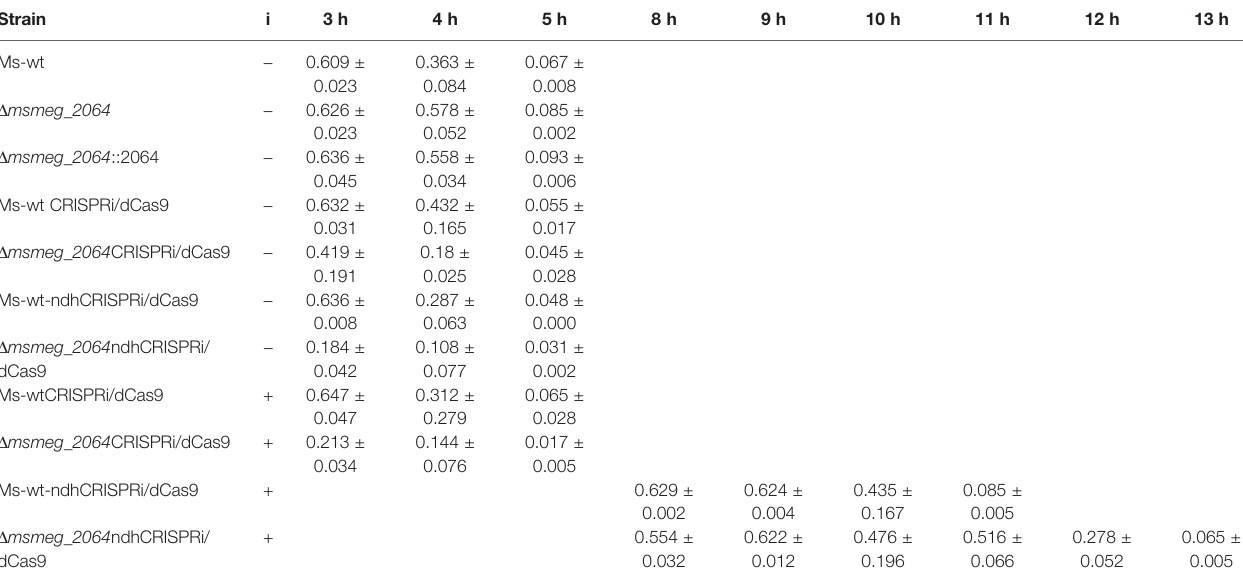
TABLE 2 | Monitoring of oxygen consumption by methylene blue discoloration under hypoxic conditions.